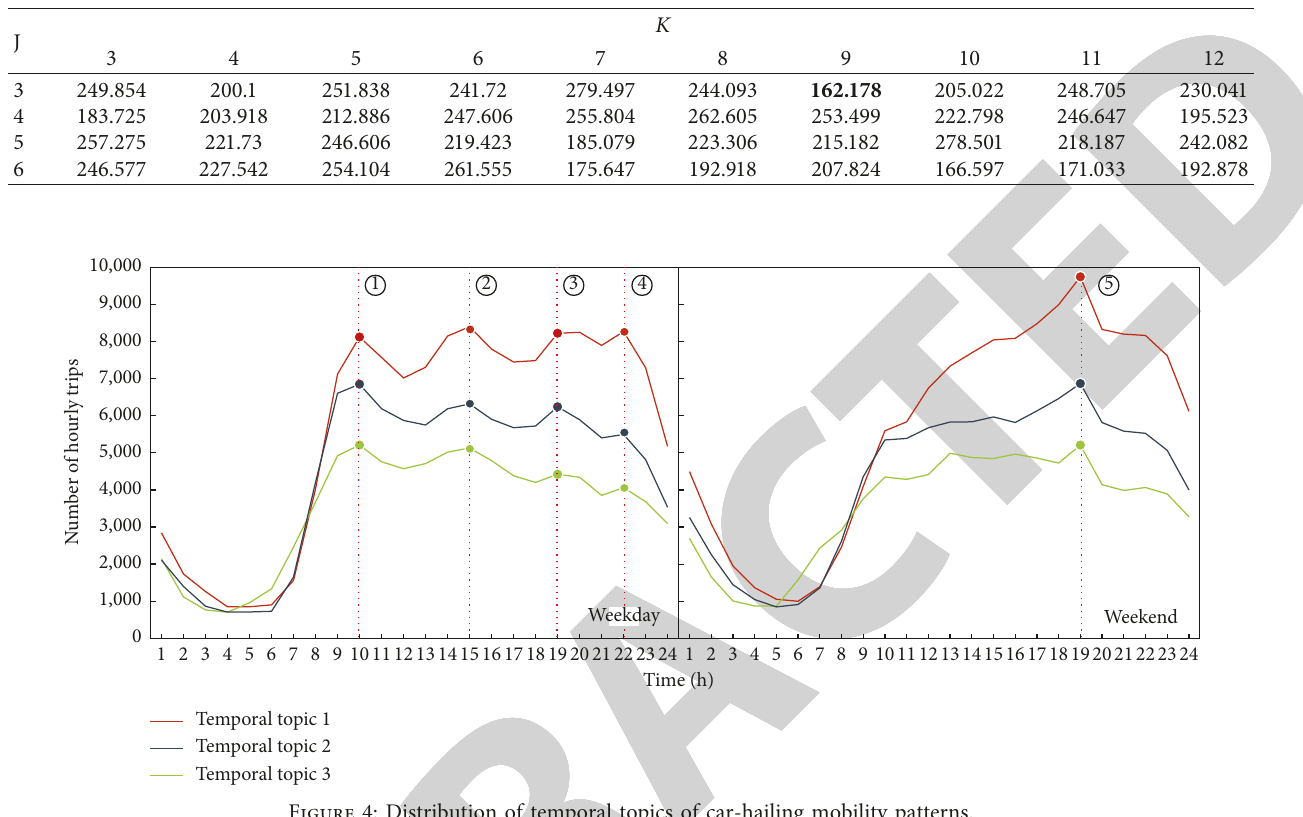
Table 3: Average perplexity distribution on different ( J , K ).